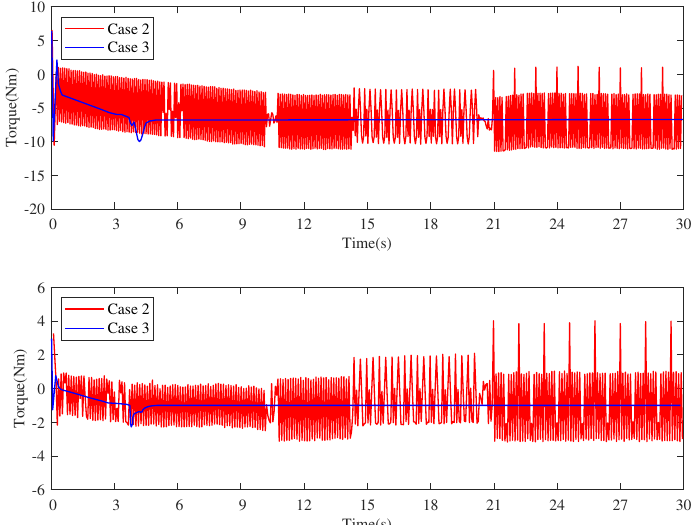
Figure 6. Torque of the robot manipulator with model uncertainty in Case 2 and Case